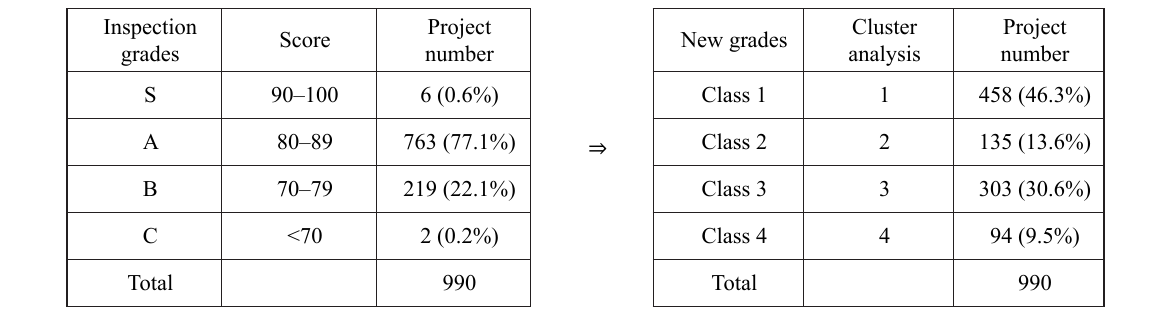
Table 1. Construction inspection grading system Table 2. New grading system in cluster